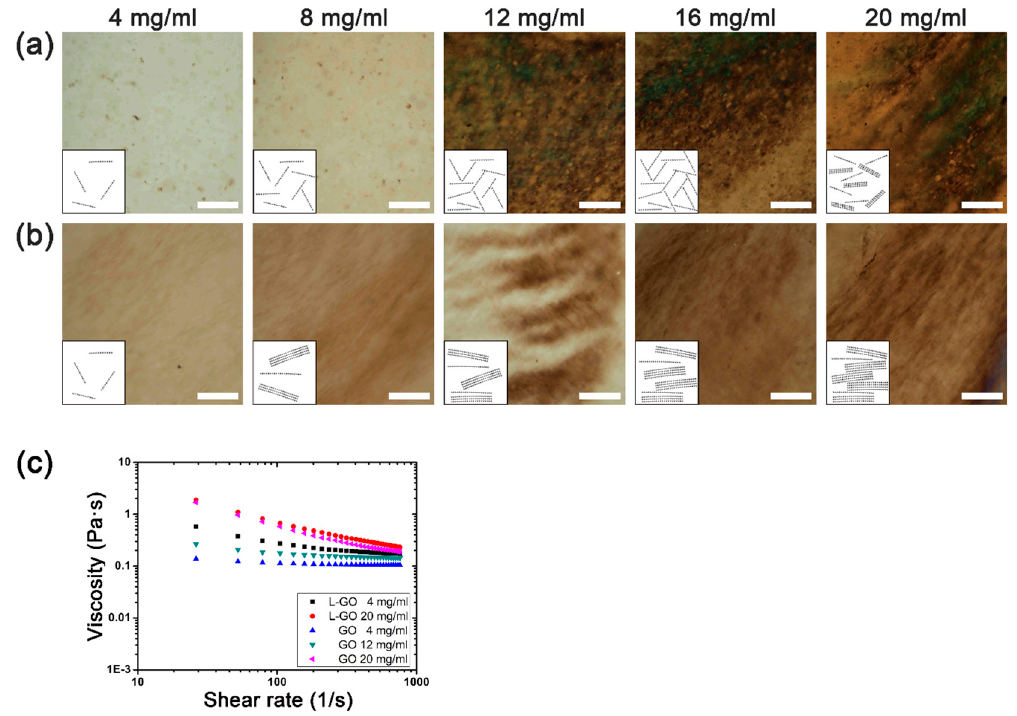
Figure 2. Polarized optical microscopy (POM) images of ( a ) GO and ( b ) L-GO suspensions according to their concentrations. Insets show schematics of GO and L-GO flakes in suspensions for each POM image. Scale bars are 200 µ m. ( c ) Plots of viscosity versus shear rate according to concentrations of GO and L-GO suspension.